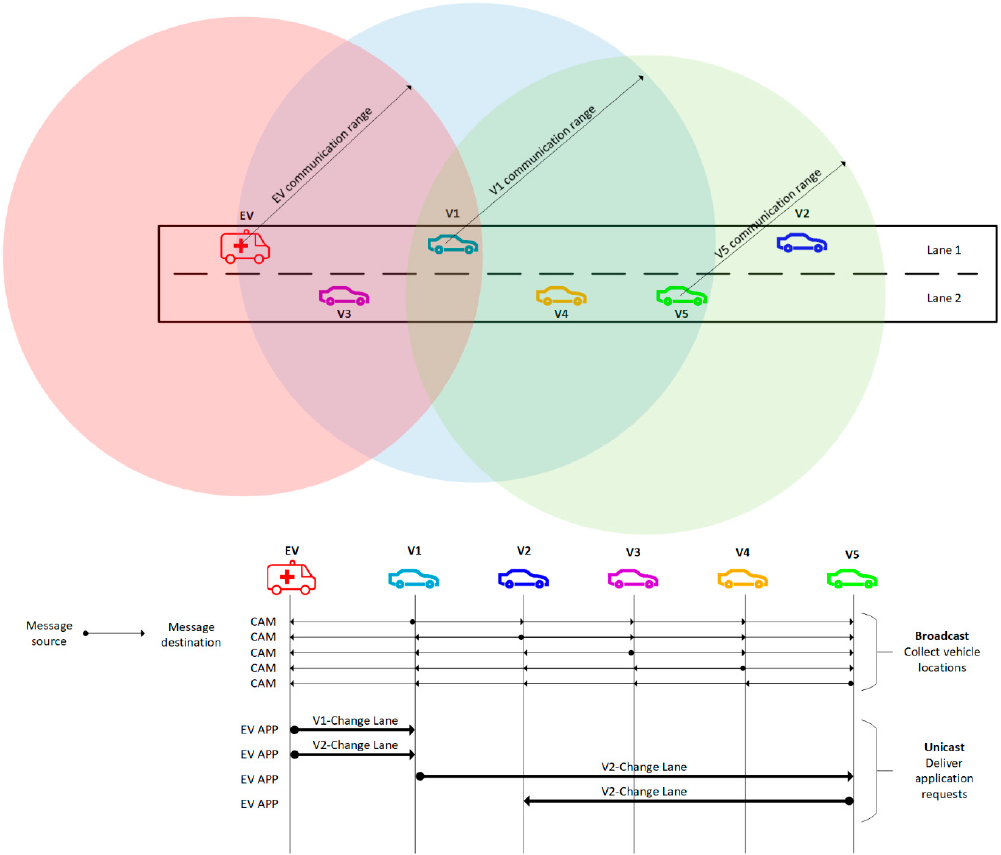
Figure 2. Illustration of the emergency vehicle warning system operation. The EV collects vehicle locations from cooperative awareness messages (CAMs), decides on the needed actions, and sends requests to corresponding vehicles. In this example, vehicles V1 and V2 are obstacles for the EV in lane 1. V1 can be reached directly. V2 is not in the EV’s communication range, therefore a routing protocol is used to find a communication route to V2. Finally, the communication message is then sent from the EV, through V1 and V5, to its destination,